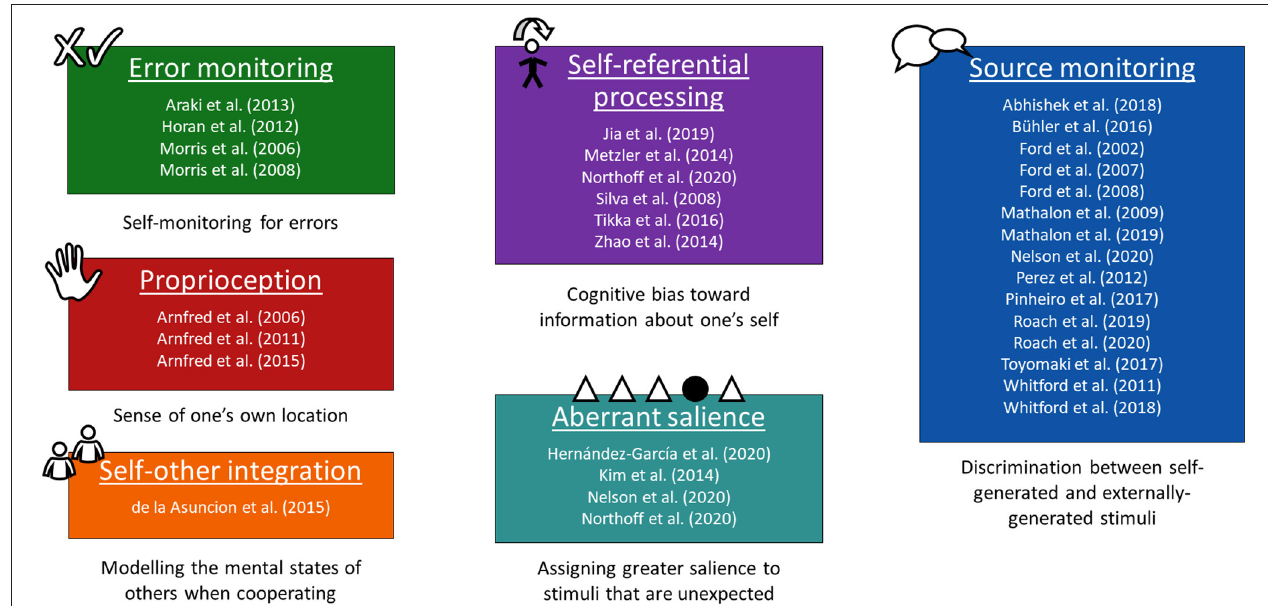
FIGURE 1 | Studies divided by experimental paradigm. The studies that were selected for inclusion in the literature review grouped into six paradigms based on the type of self-related task used in their experimental design.